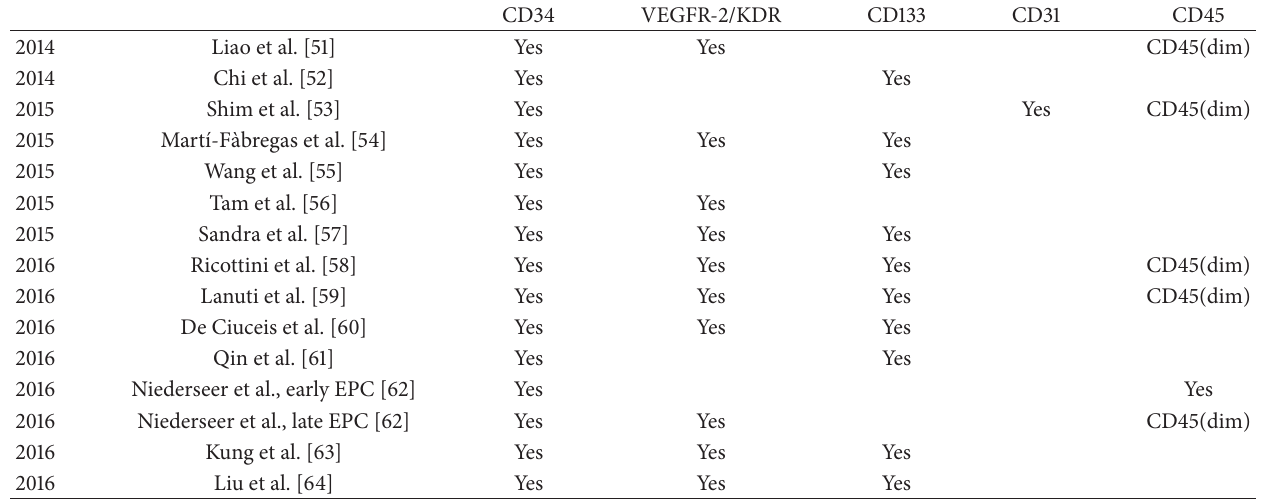
Table 1: Evolution of cell-surface markers for endothelial progenitor cell isolation